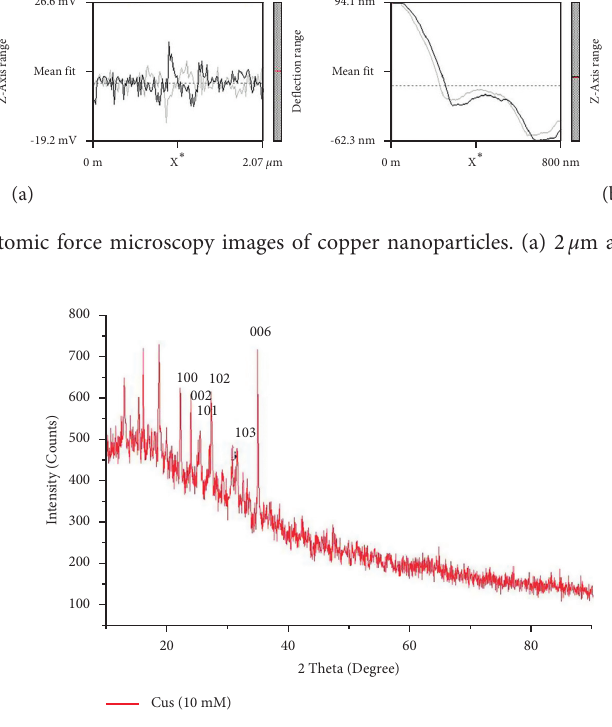
Figure 5: X-ray diffraction spectrum of green-synthesized copper nanoparticles shows crystalline